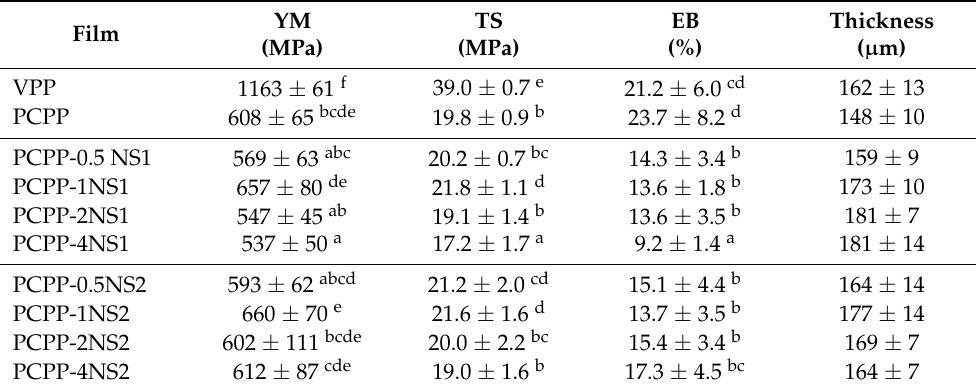
Table 1. Tensile parameters of control and nanocomposite